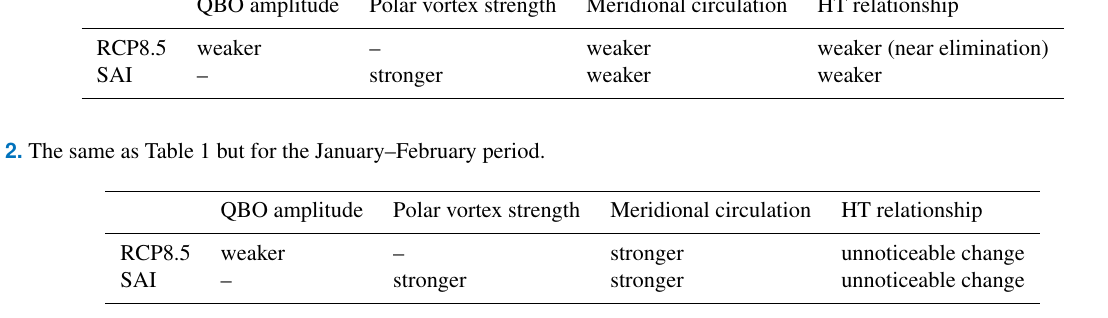
Table 1. The relative composite differences (QBOe–QBOw) of different physical mechanisms influencing the strength of the HT relationship in November–December. The weaker and stronger mechanisms are relative to the PDC. A blank indicates insignificant changes compared to the PDC.